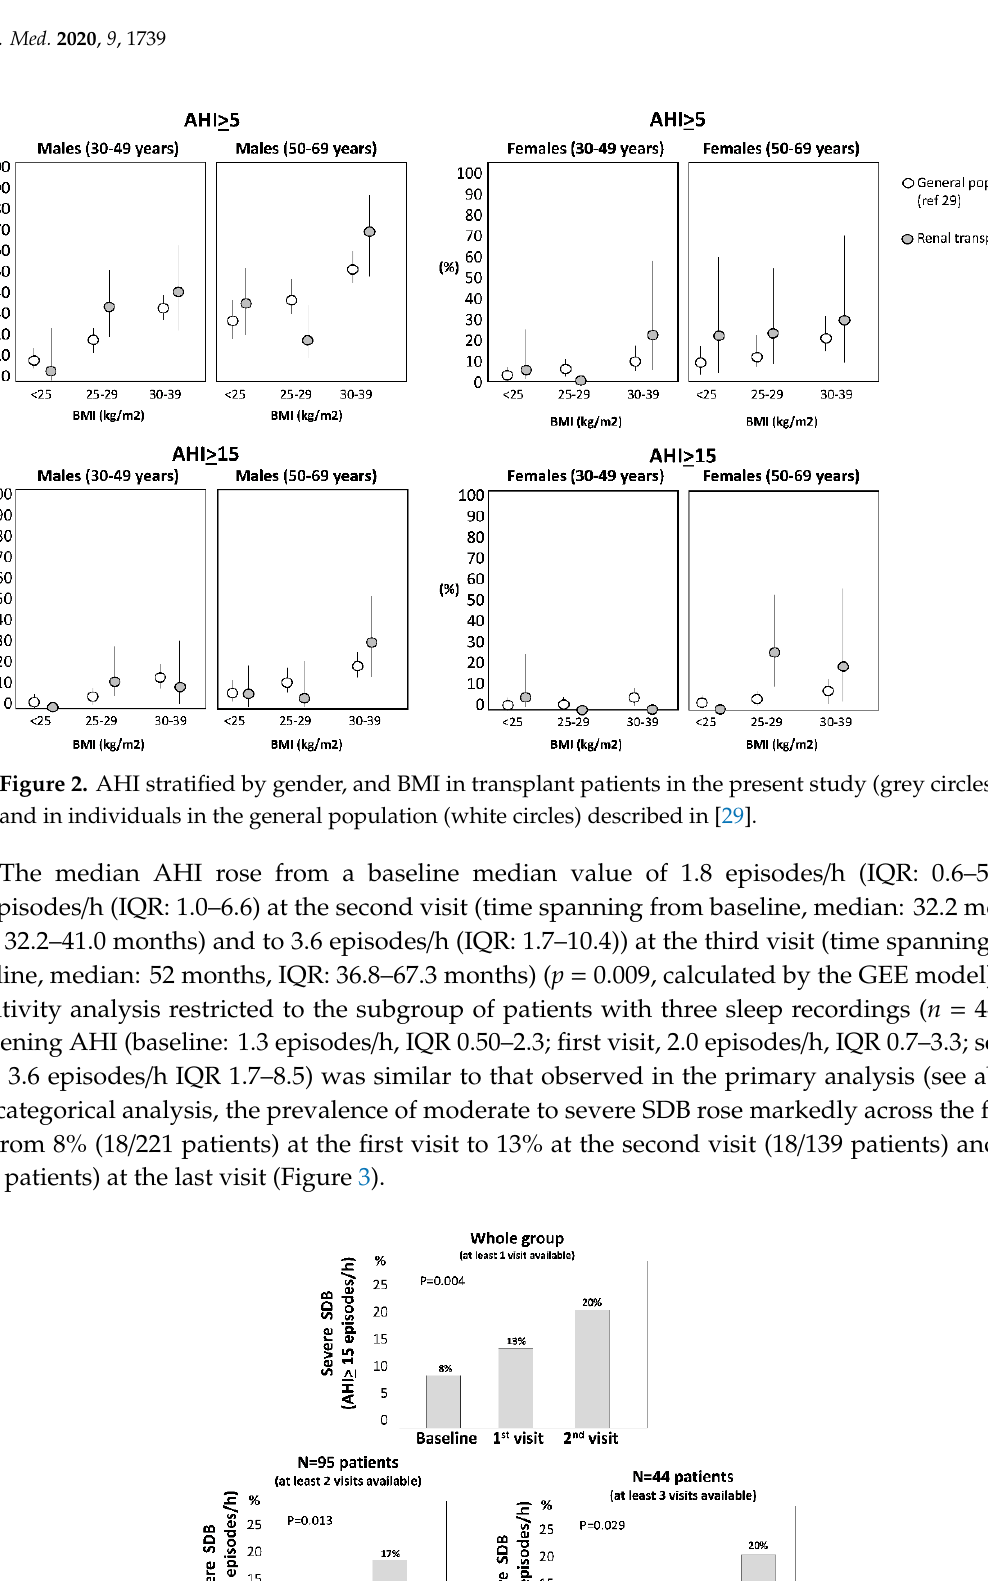
Table 2. Adjusted multiple generalized estimating equations (GEE) of Apnea Hypopnea Index (AHI) and minimal nocturnal O 2 saturation over time. The model includes all univariate correlates of AHI at baseline with p < 0.10 (age, gender, diabetes as well as the BMI and estimated glomerular filtration rate (eGFR). BMI and eGFR are tested as repeated measures). Data are regression coefficients, 95% CI and p value.